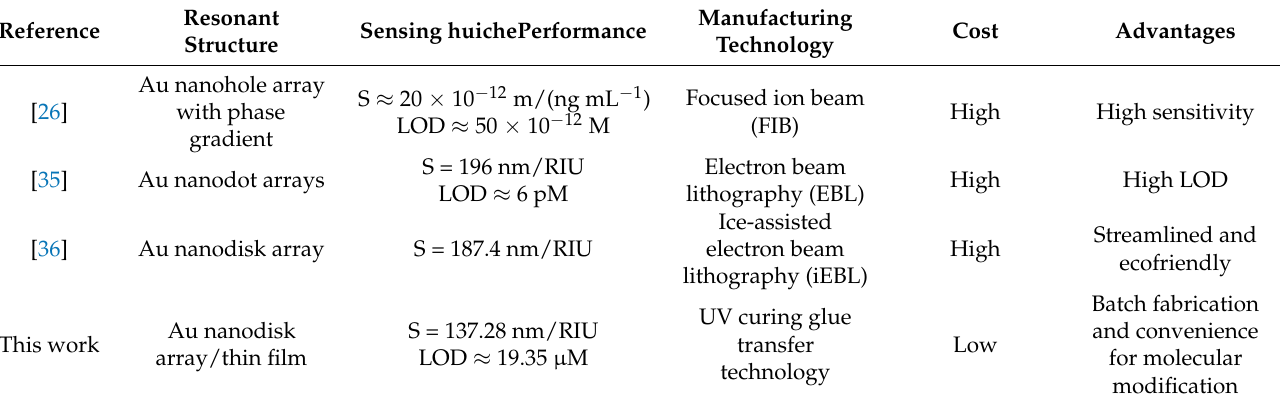
Table 1. Comparison of FOSPR sensing tips prepared by different processing